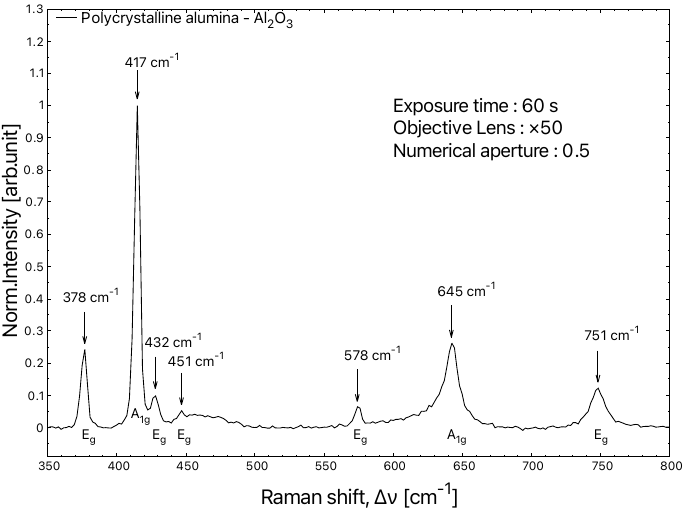
Figure 2. Typical Raman spectrum of polycrystalline alumina. The two modes at 417 cm − 1 and 645 cm − 1 are of type A 1 g . The five modes at 378 cm − 1 , 430 cm − 1 , 451 cm − 1 , 576 cm − 1 and 750 cm − 1 have E g symmetry. The spectrum is normalised to the strongest peak at 417 cm − 1